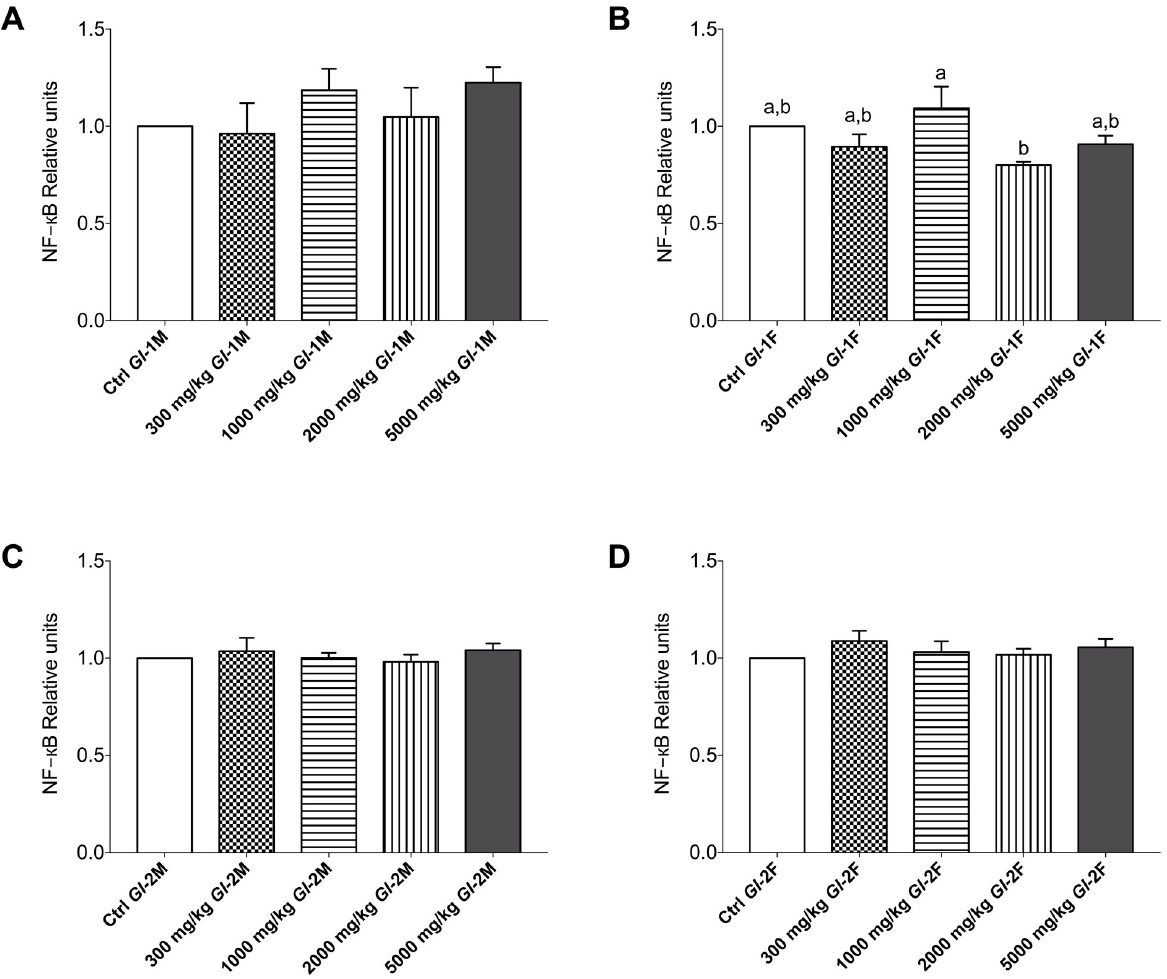
Fig 7. Renal NF- к B protein of kidney tissue from male (M) or female (F) Wistar rats fed with the control diet (Ctrl) and different doses of standardized Gl -1 or Gl -2 extracts of Ganoderma lucidum for 14 experimental days. Data are presented as mean ± SEM per experimental group. Different letters on a column indicate significant differences, p < 0.05. Values ( p ) correspond to one-way ANOVA from Tukey’s multiple comparison test. Densitometry data were generated from Western blots shown in Fig 8. A–B: Administration of the Gl -1 extract. C–D: Administration of the Gl -2 extract. The dose administered per experimental group is described in the materials and methods section.